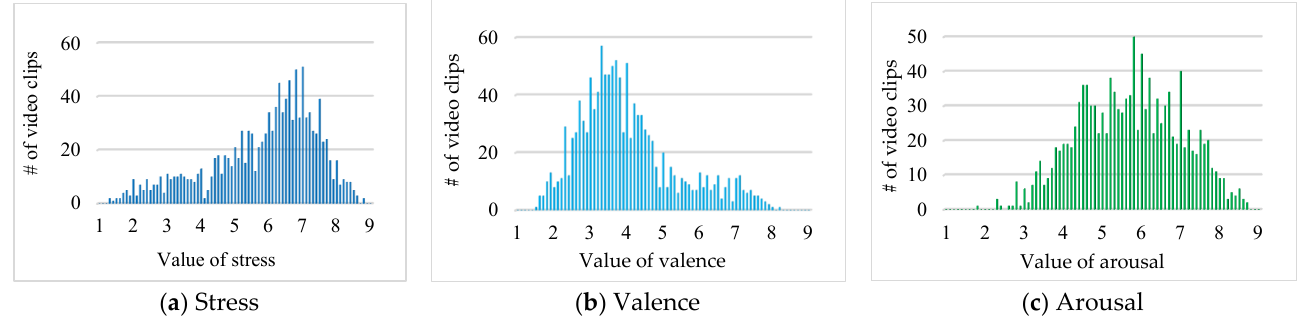
Figure 5. Distribution of all classes.